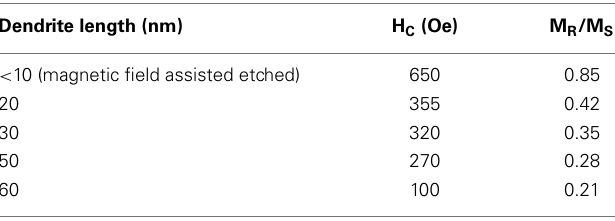
Table 2 | Coercivity dependence on the length of the dendrites